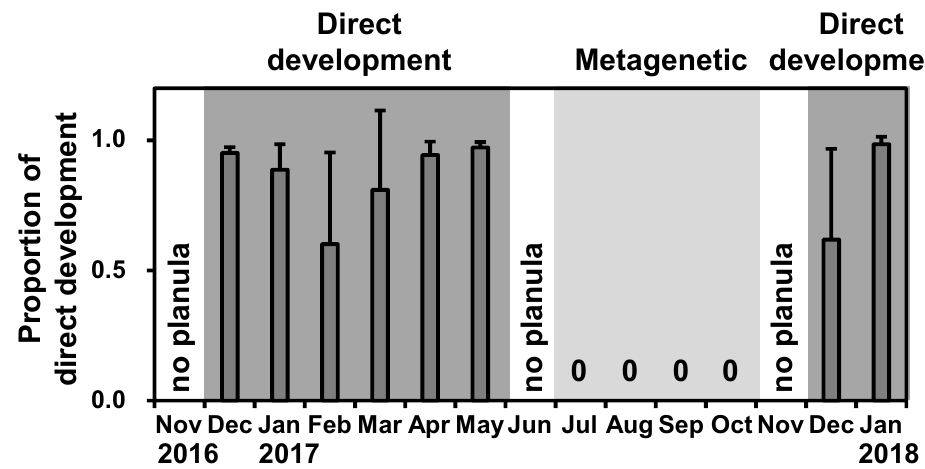
Fig 5. Temporal variations in proportion of direct development from planulae. Bars and error bars in the top figure are mean values and SD. No planula indicates that no female bore planulae. Dark and light shades indicate the direct- development and metagenetic periods,